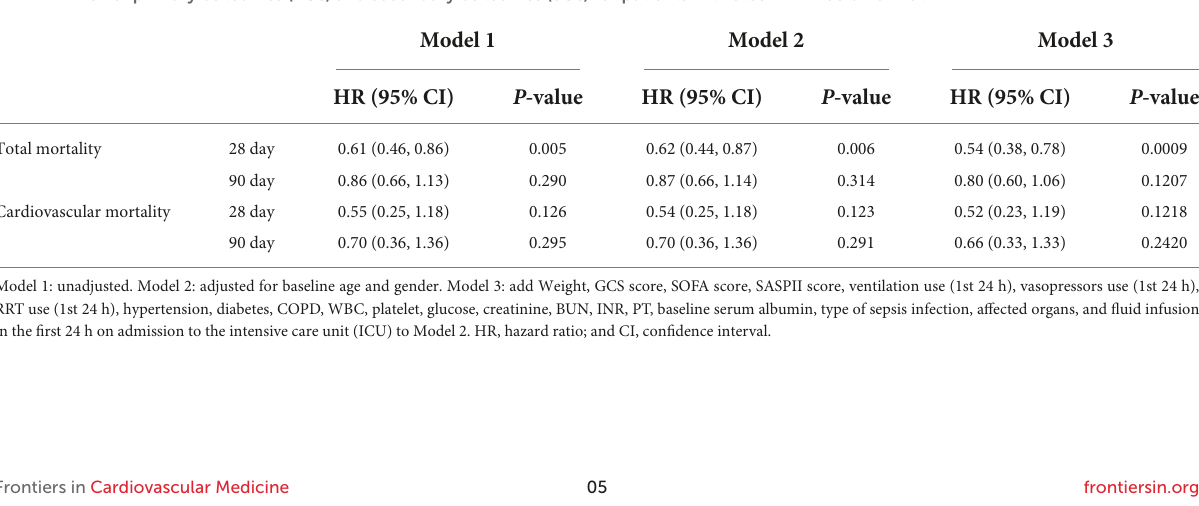
TABLE 2 Risk of primary outcomes (POs) and secondary outcomes (SOs) for patients with albumin infusion or